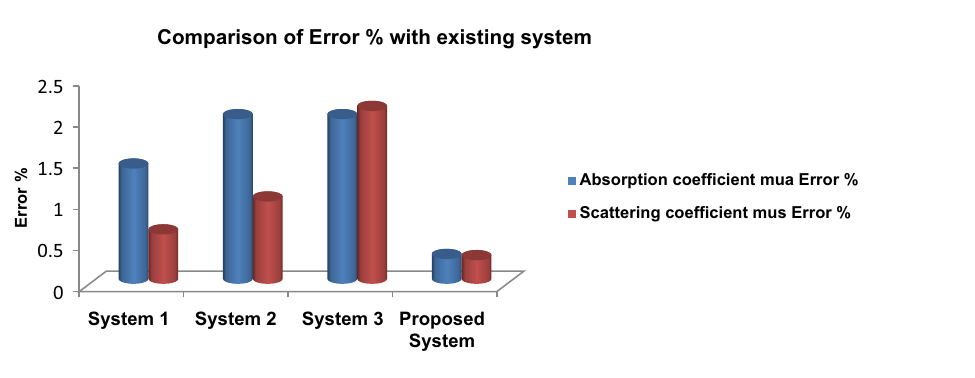
Figure 9. Comparison of error % with the existing